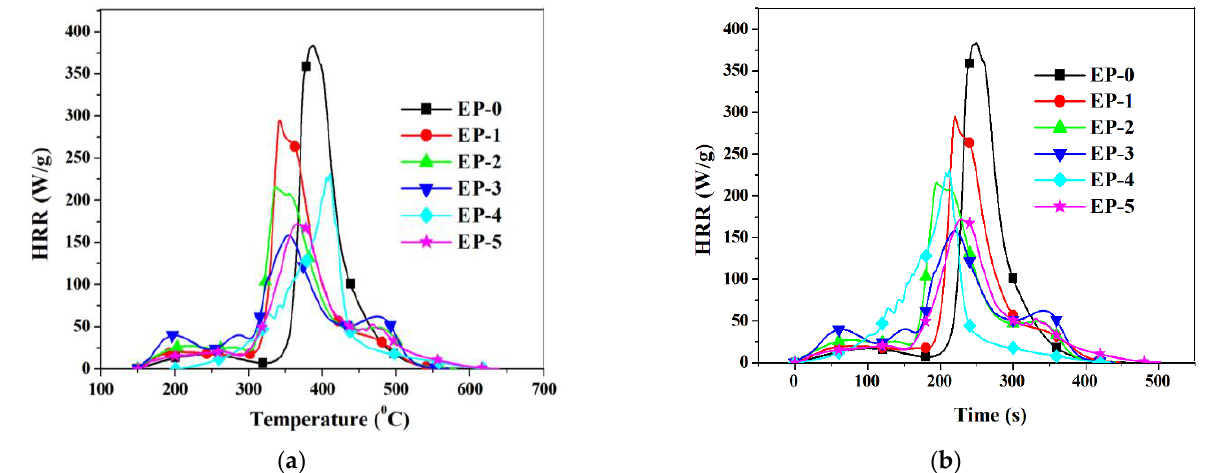
Figure 12. ( a ) Heat release rates versus temperature for epoxy composites; ( b ) Heat release rates versus time for epoxy composites. Table 3. Data obtained by MCC analysis for epoxy composites.